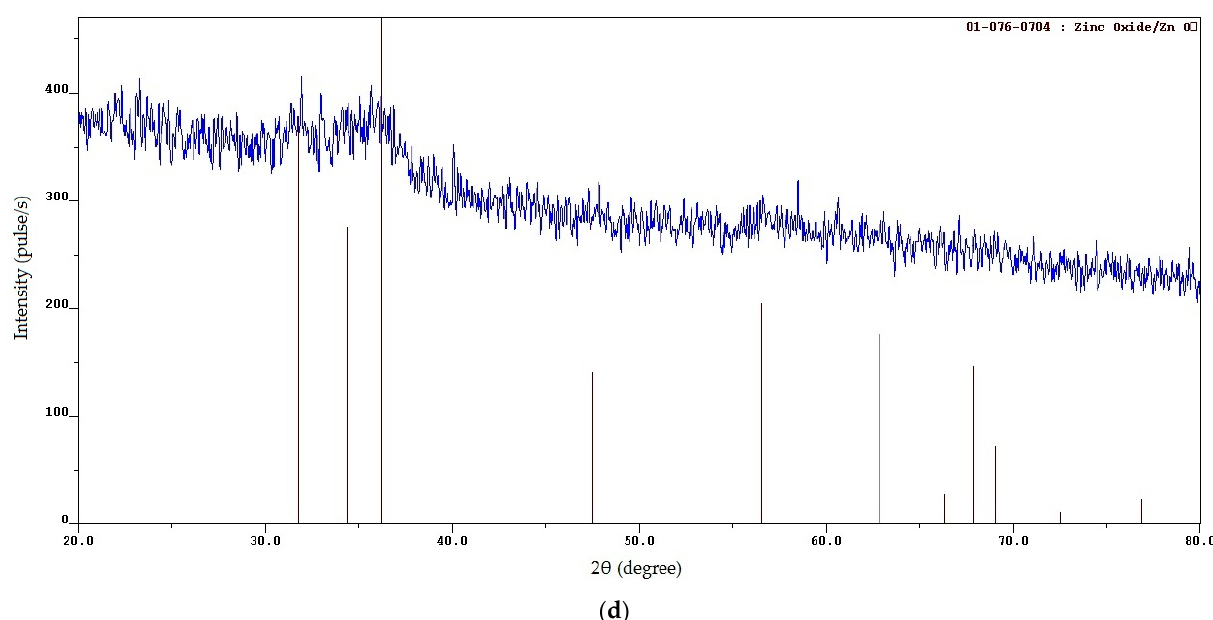
Figure 2. XRD patterns of the SCS product at various φ : ( a ) φ = 0.25; ( b ) φ = 1; ( c ) φ = 2; ( d ) φ = 3.